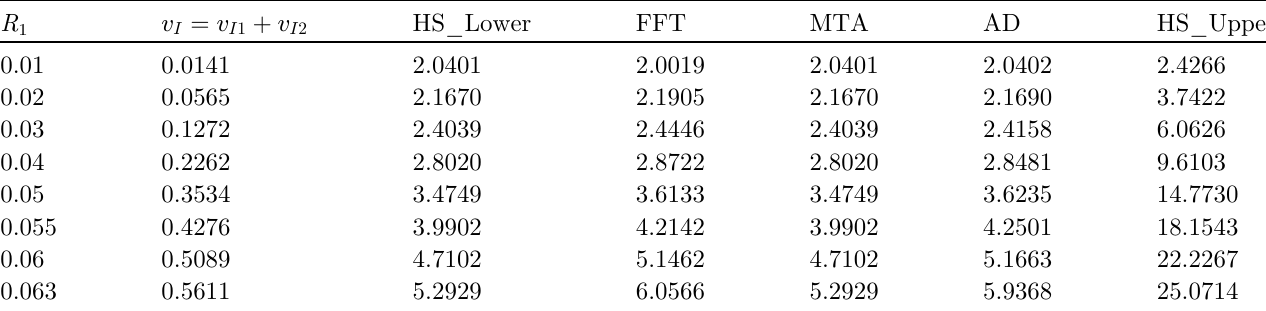
ffiffiffi p R 2 2 .